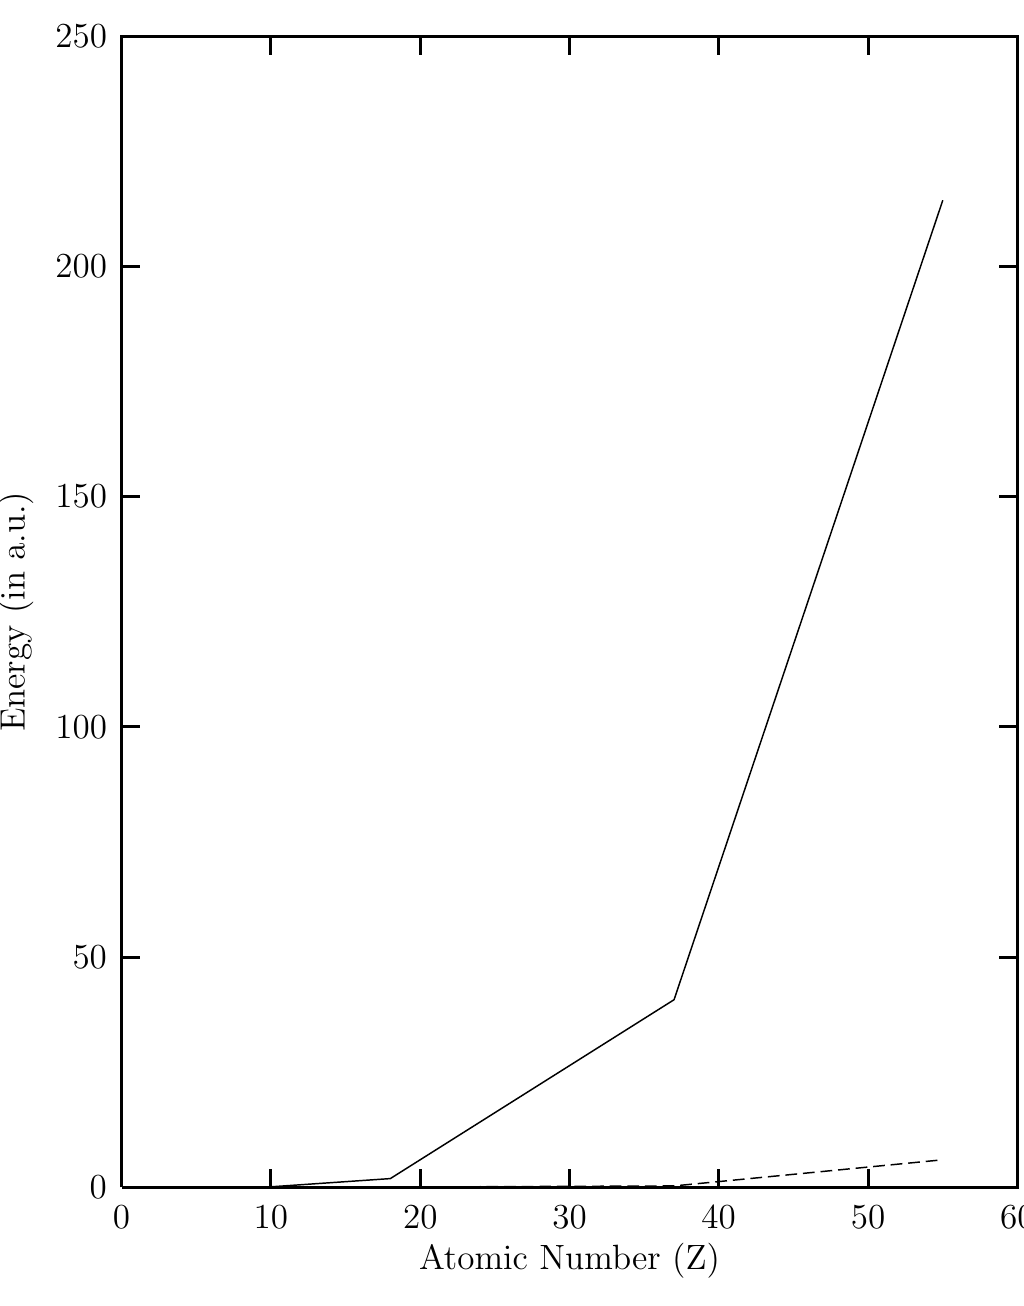
| (solid line) and | E DF − E HF gr gr